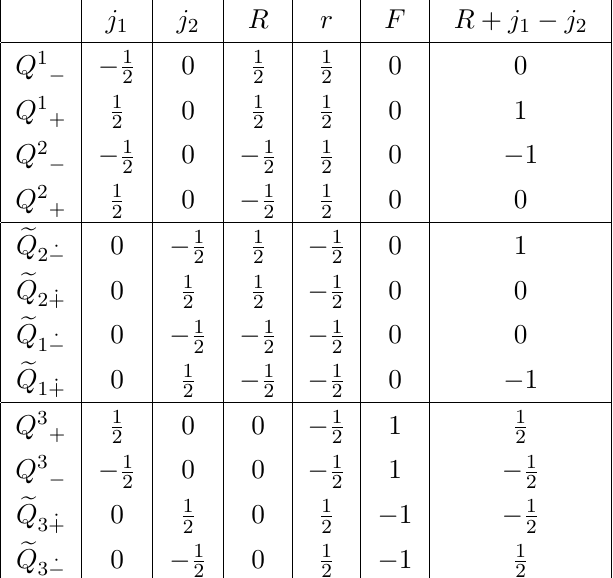
Table 5 . Supercharges of the 4d N = 3 supersymmetry. Upon partial topological twist, the spin j 1 (cid:0) j 2 along F g is replaced by a linear combination R + j 1 (cid:0) j 2 summarized in the last column. It clearly illustrates that topological reduction of a 4d N = 3 theory on F g preserves only 2d N = (2 ; 2) supersymmetry, just like topological reduction of a 4d N = 2